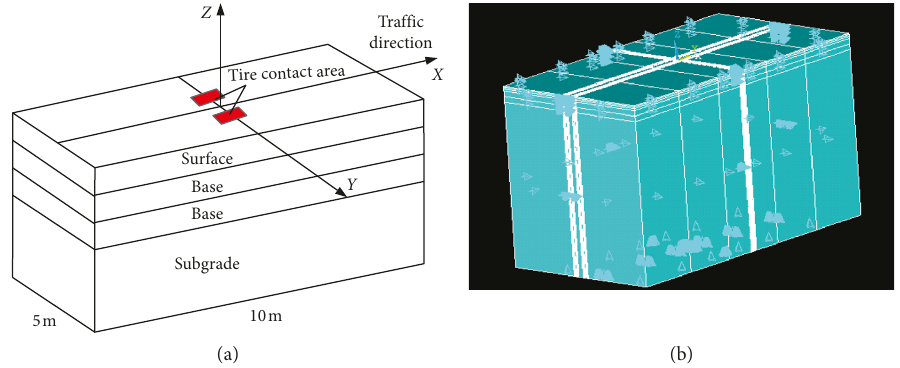
Figure 1: The 3D-FE model: (a) dimension; (b) boundary conditions.